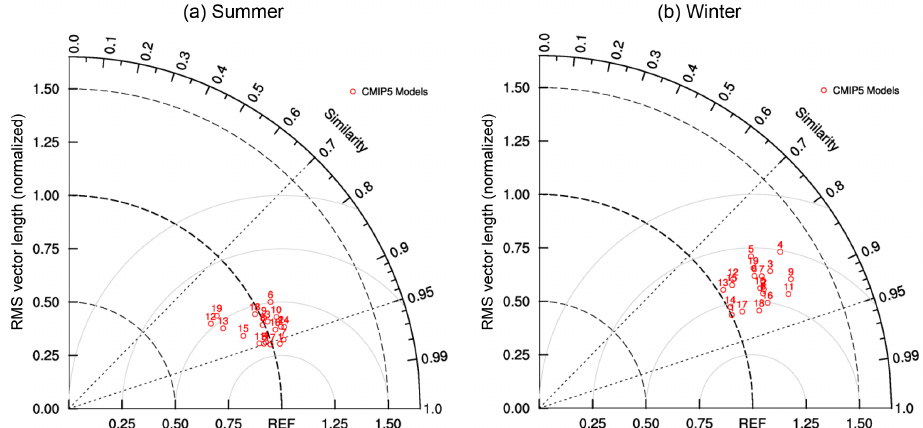
Figure 6. Normalized pattern statistics of climatological mean 850hPa vector winds in the Asian–Australian monsoon region (10 ◦ S–40 ◦ N, Reanalysis 2 data during the period from 1979 to 2005. The RMS length and the RMSVD have been normalized by the RMS length derived from NCEP2. The data were excluded from the statistics in areas with a topography higher than